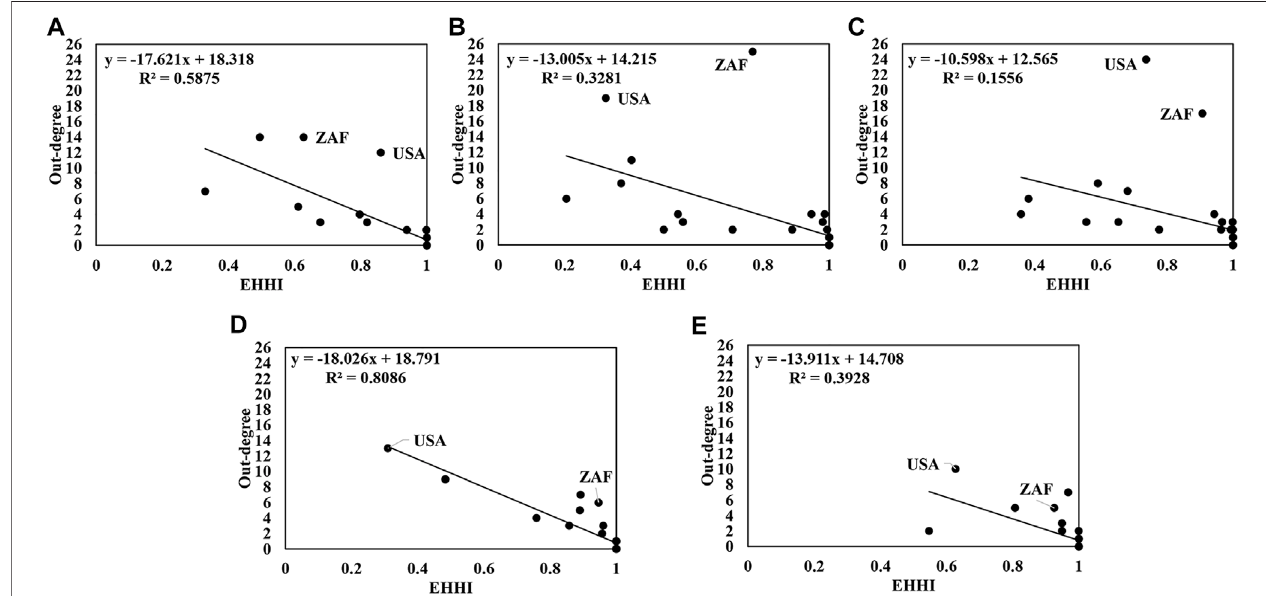
FIGURE 9 | The scatter plot between the number of export partners and the EHHI ( (A – E) correspond to the years of 2000, 2005, 2010, 2015, and 2019, respectively).